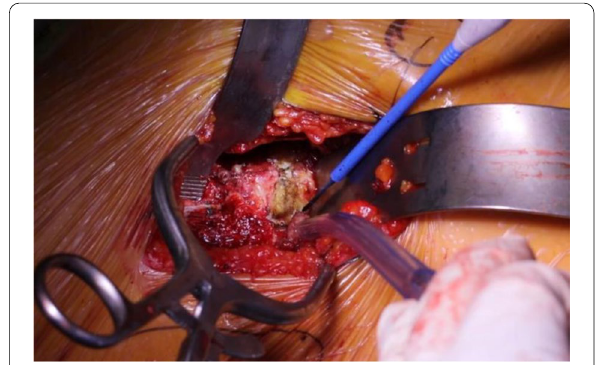
Fig. 8 Elevation and visualization of the proximal femur without the necessity of a femoral bone hook